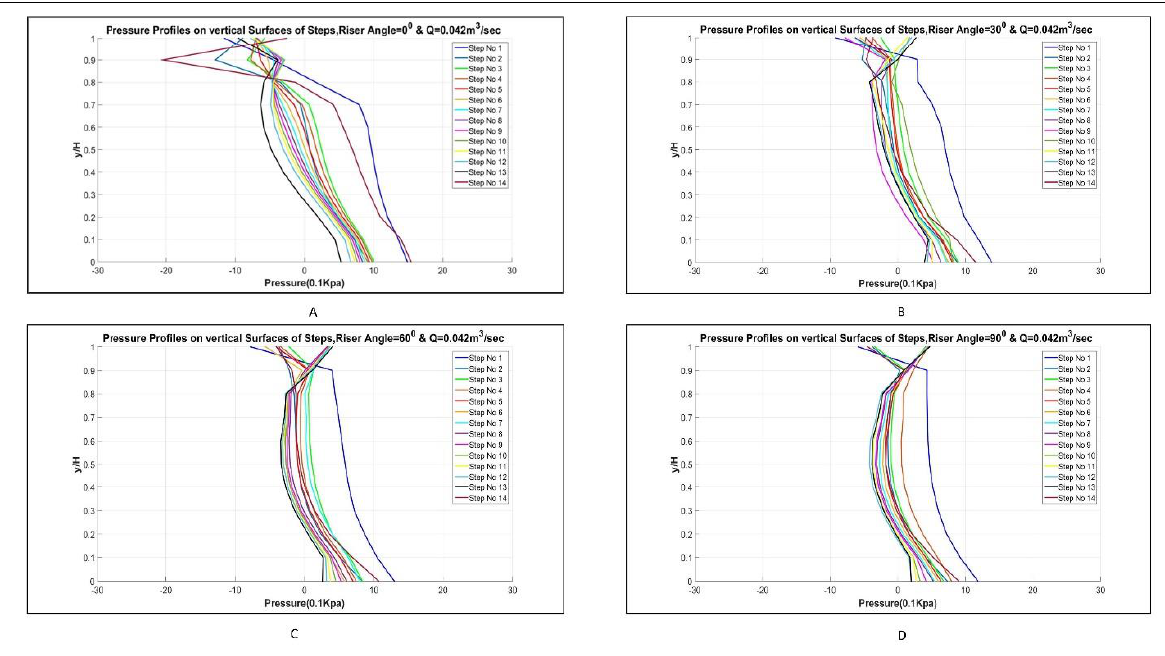
Figure 11. Pressure profiles for ( A ) simple stepped, ( B ) 30°, ( C ) 60°, and ( D ) 90° curved risers spillway for the head of 160 mm.